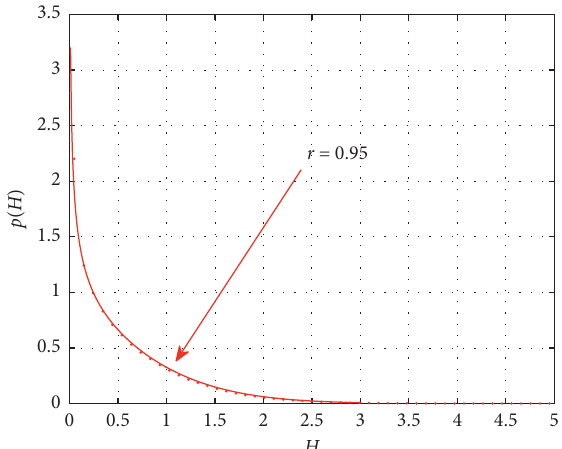
and velocity x : (a) analytical results; (b) Monte Carlo results. 1 2